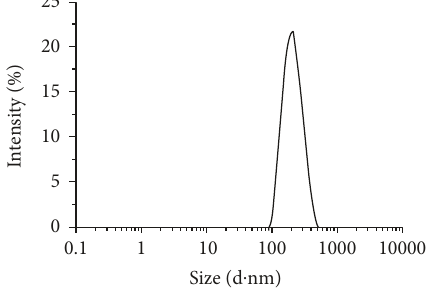
Figure 3: Particle size distribution pro fi les of HA/PSO/C NPs. Particle size distribution curves of HA/PSO/C NPs measured by a particle analyzer.